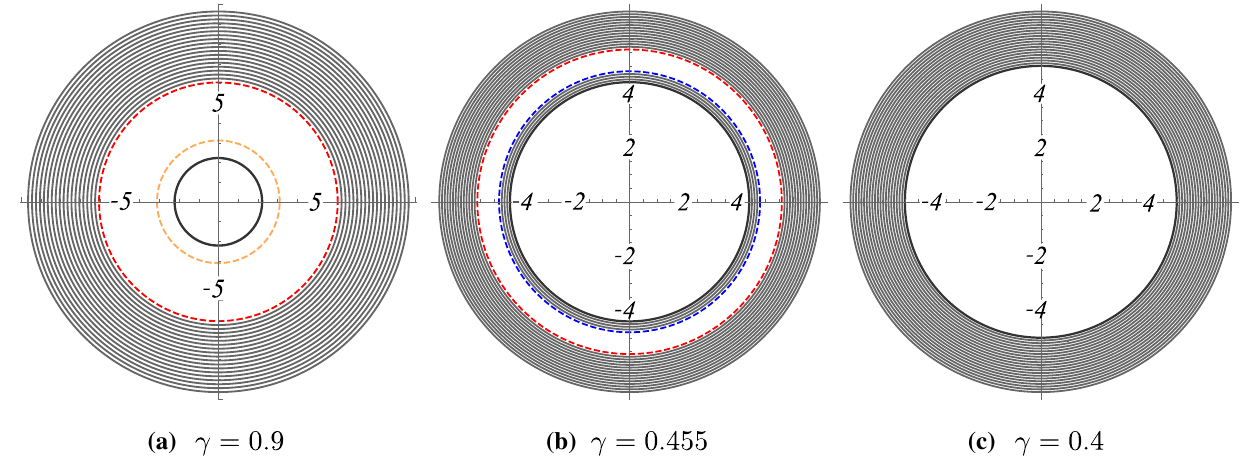
Fig. 2 The possible qualitatively different structures of the accretion diskthatcanoccurfor a weaklynaked,and b , c stronglynakedsingular- ities.Thecurvaturesingularity r cs isrepresentedbytheblackline,while